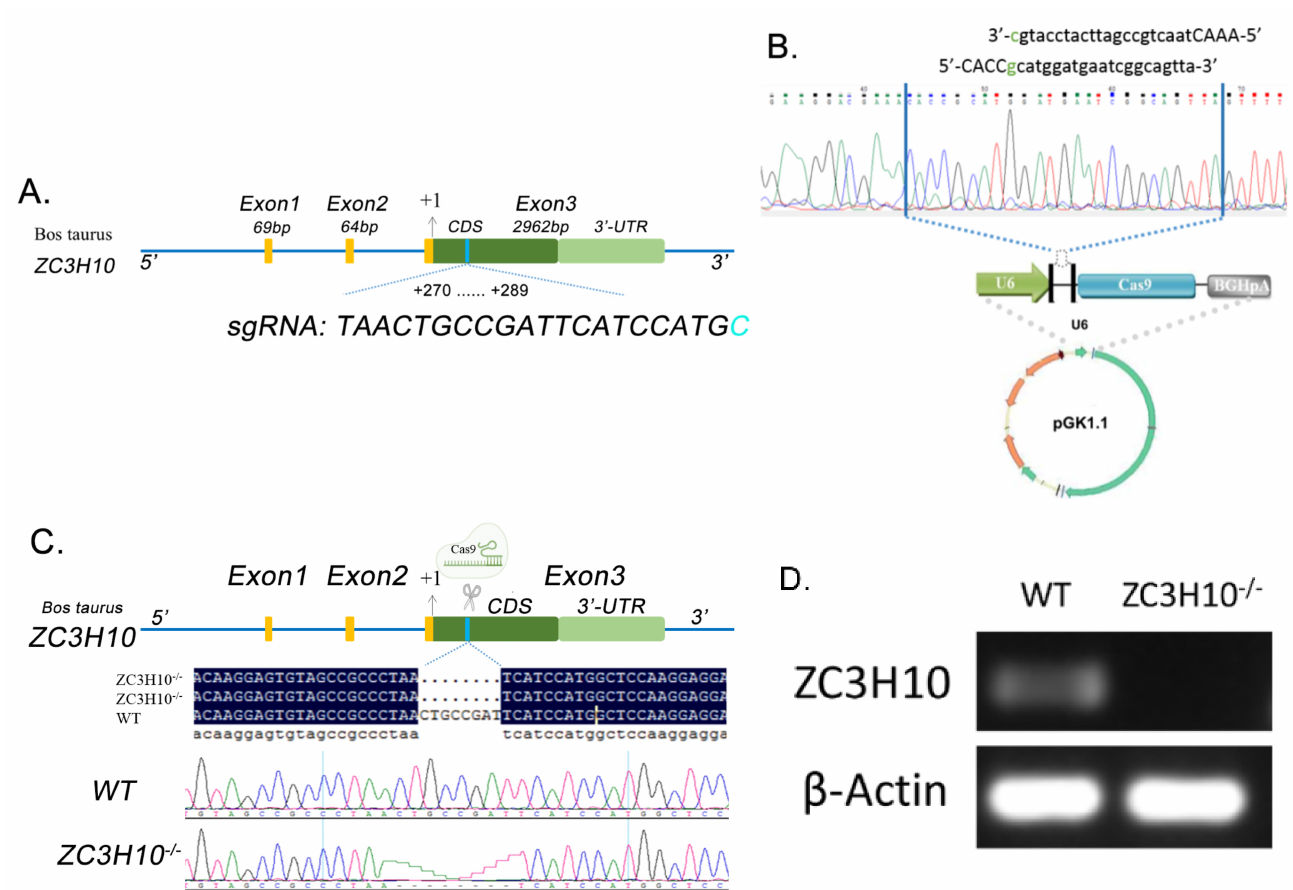
Figure 3. Construction of ZC3H10 − / − bovine fibroblast cells. ( A ) Structure of ZC3H10 and design of gRNA sequence of CRISPR/Cas9. ( B ) Construction of the plasmid of pGK1.1-ZC3H20. ( C ) Validation of deletion sequences. ( D ) RT-PCR result of wild and ZC3H10 − / − BFFs.